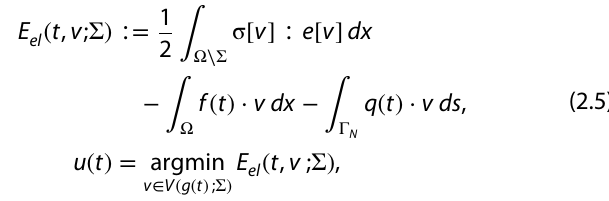
Fig. 1 Example of a domain with a